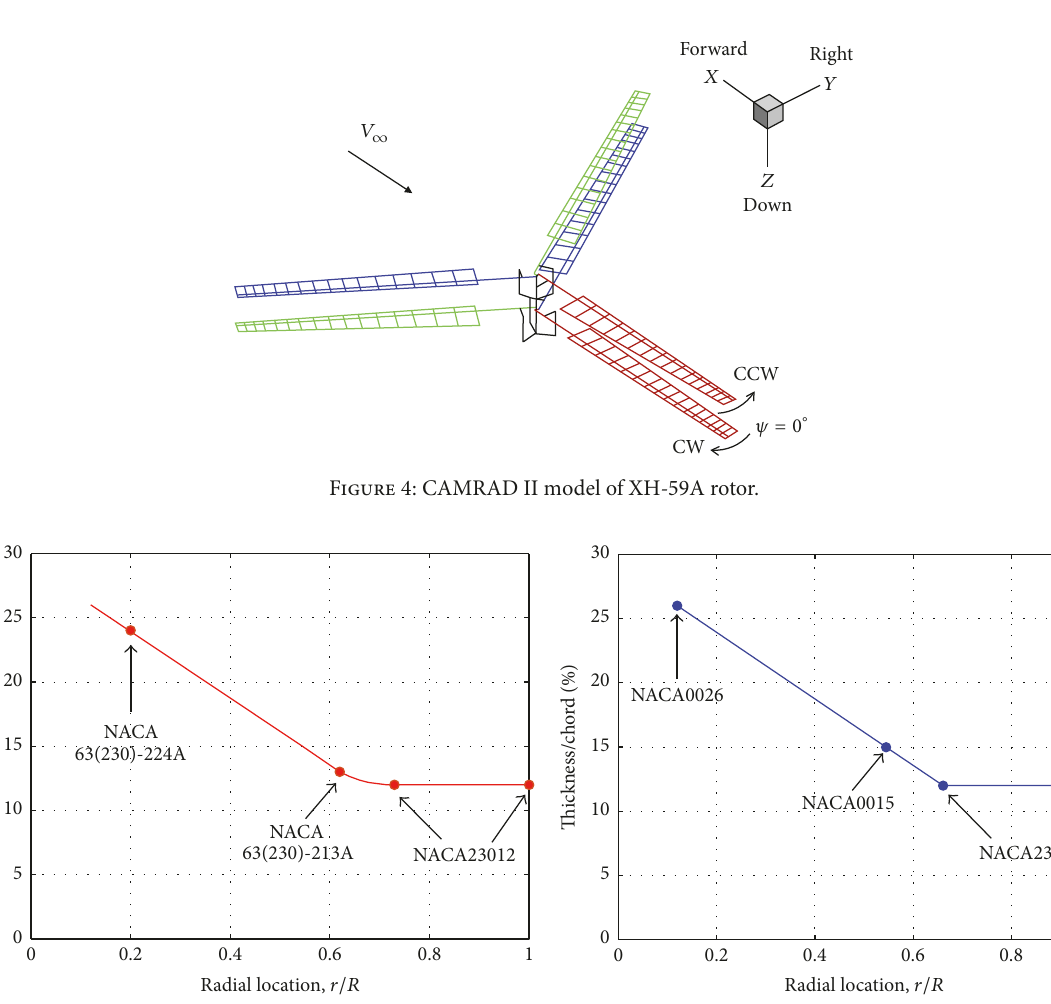
Figure 6: Aerodynamic panel